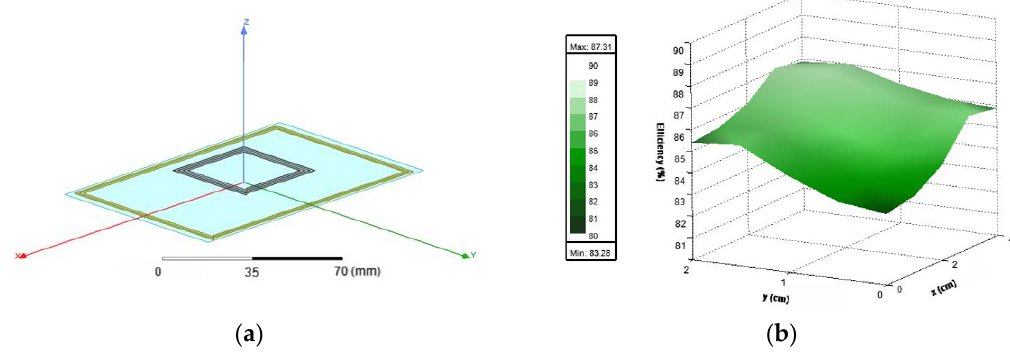
Figure 7. ( a ) 3D Model representing the optimized coils and the representation of the charging surface; ( b ) electromagnetic simulation results of the efficiency (%) of the optimized coils.